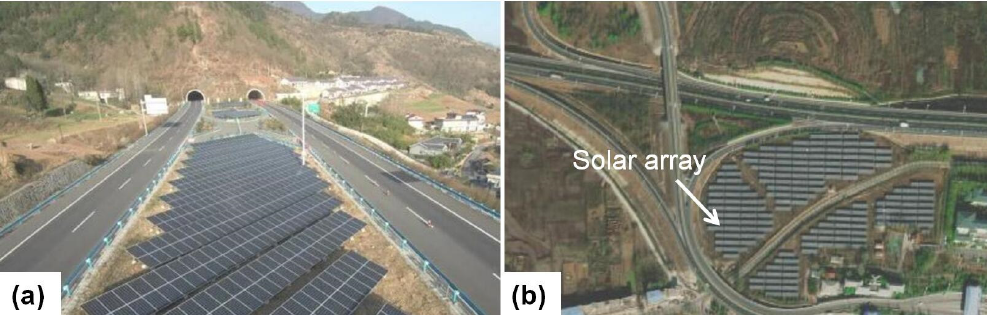
Figure 1. Solar array mounted on spare spaces of ( a ) a median of an expressway in Hubei, China and ( b ) an interchange of Ji-Qing Expressway in Jinan, China (117.00° E, 36.56° N).